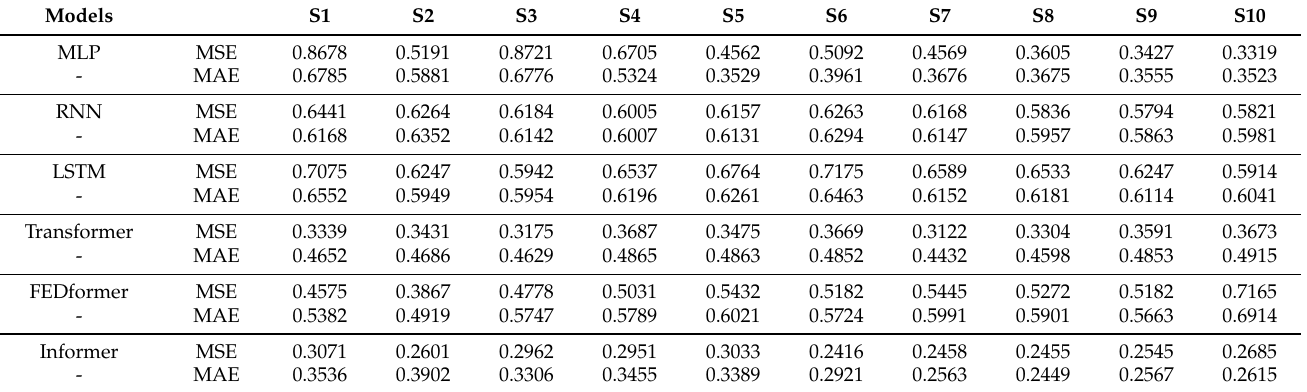
Table 7. Efficiency statistics of 6 DL models for 10 combinations of input variables during